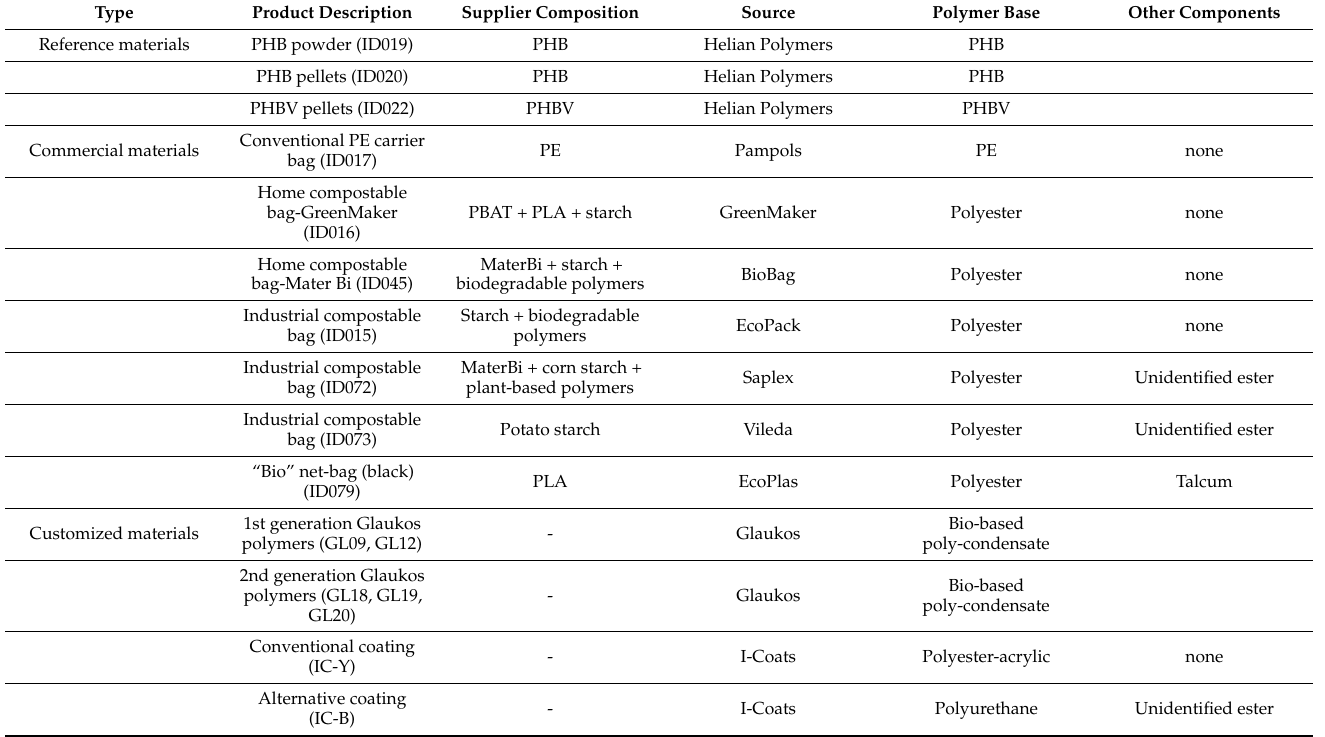
Table A2. Comparison of logistic models to fit experimental data for readily biodegradable